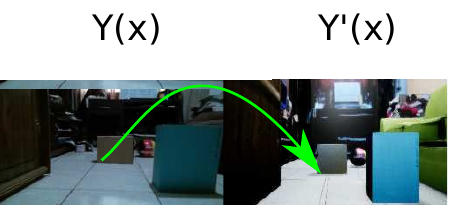
Figure 3. The change of the domain by GANs from the real world to its virtual